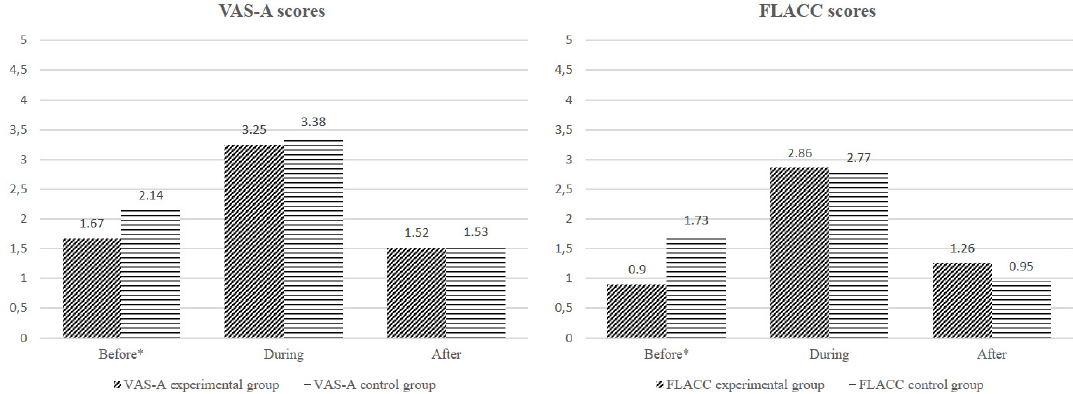
Figure 1. Mean VAS-A and FLACC scores before, during and after the blood collection (∗ 𝑝 ≤ 0.05 ).